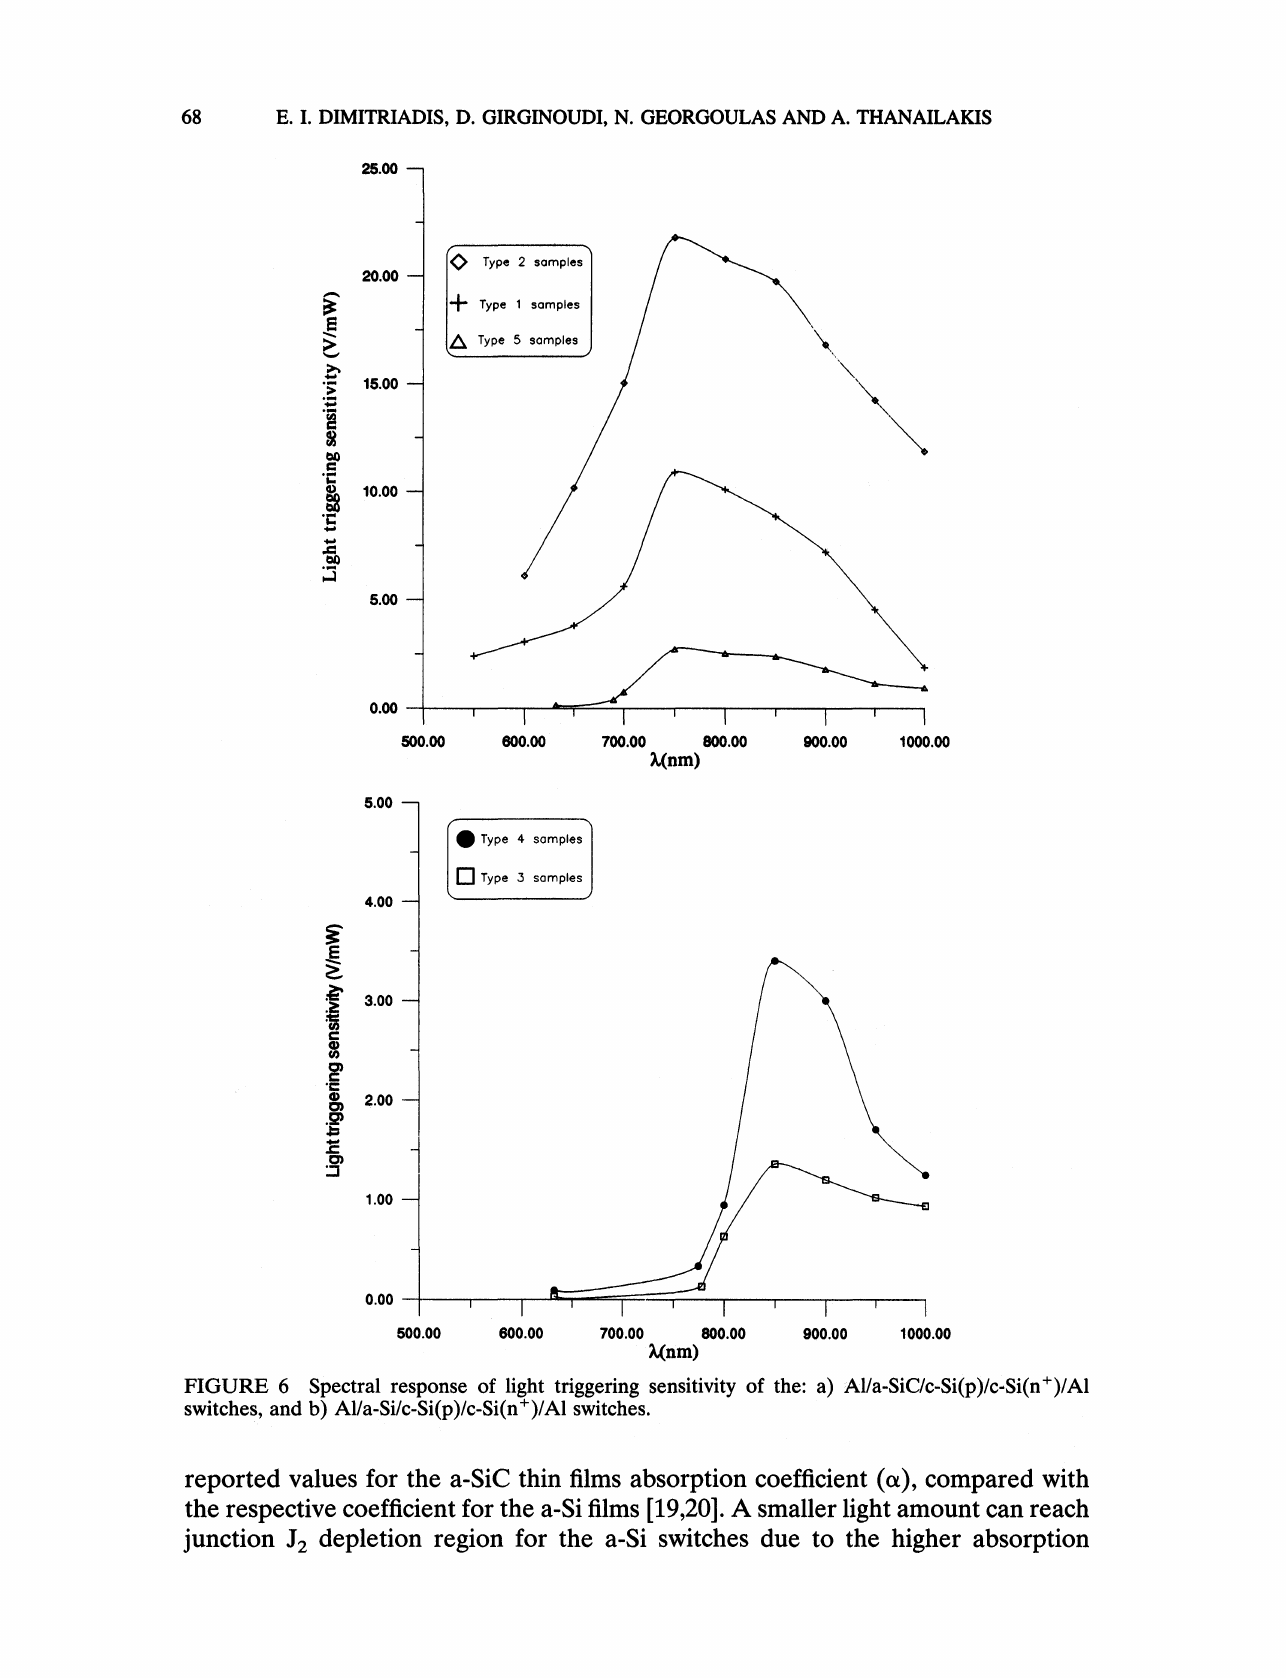
FIGURE 6 Spectral response of light triggering sensitivity of the: a) A1/a-SiC/c-Si(p)/c-Si(n/)/A1 switches, and b) Al/a-Si/c-Si(p)/c-Si(n/)/A1 switches. reported values for the a-SiC thin films absorption coefficient (a), compared with the respective coefficient for the a-Si films [19,20]. A smaller light amount can reach junction J2 depletion region for the a-Si switches due to the higher